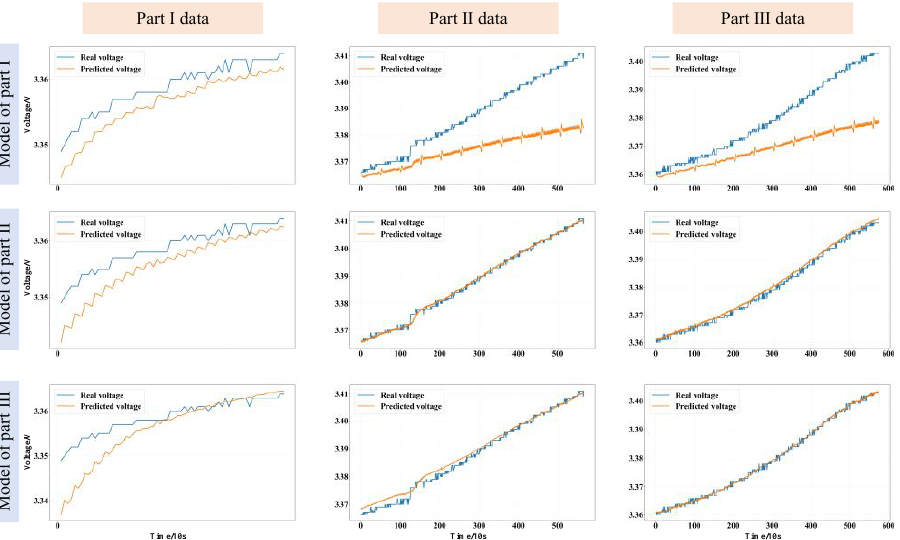
Figure 10. The prediction results of each partitioned model were used to predict the data of different partitions.